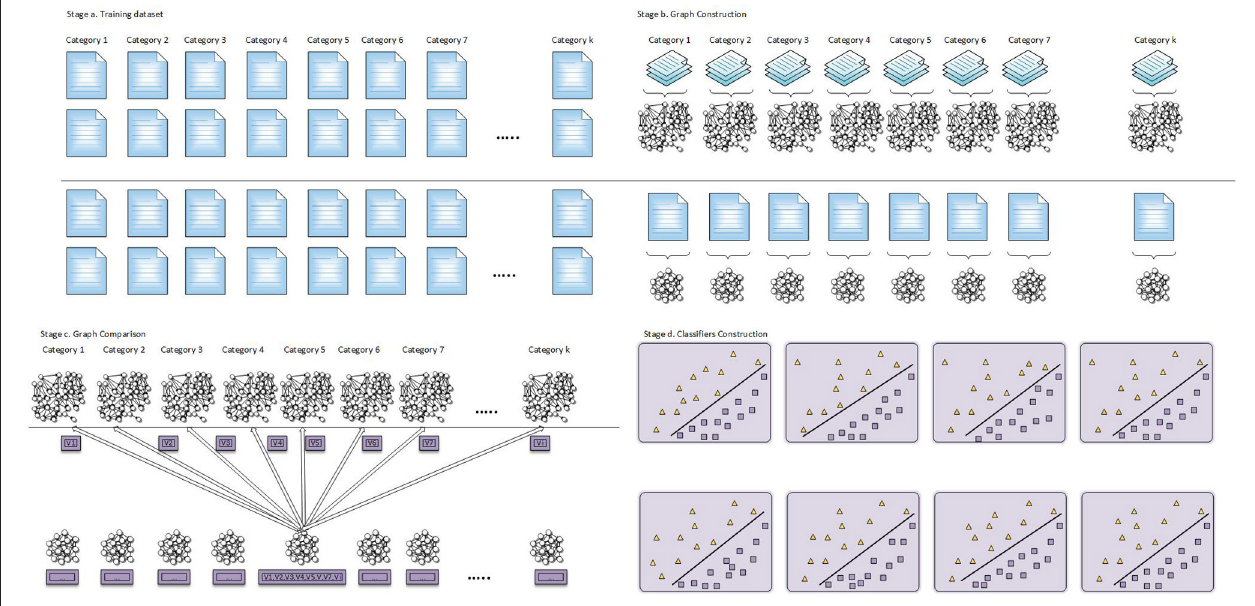
FIGURE 5 | Stages for graph and vector construction and